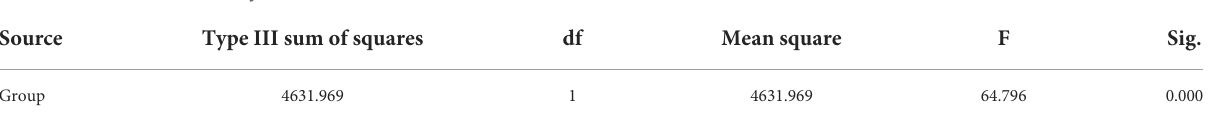
TABLE 4 Tests of between-subjects